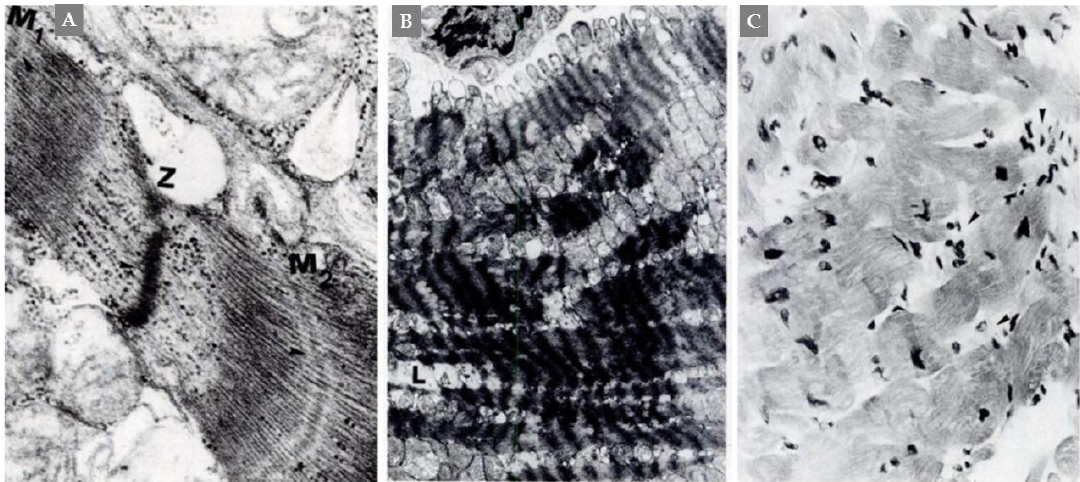
Figure 4. A case of catecholamine-induced “dilated cardiomyopathy”. Panel ( A ), detail of contraction bands that suggests mechanism of damage produced by supercontraction. Two hypercontracted hemisarcomeres delimited by arrows (Z-M1) and (Z-M2) are shown. Between them, initial myofibrolysis is evident. Panel ( B ), supercontraction of sarcomeres associated with intracellular Ca overload and progressing focally to myofibrolysis (L). Panel ( C ), contraction band necrosis of myocardiocytes with foci of inflammatory reaction (arrows). From Frustaci et al., Chest 1991:382-85 with permission. 13. Is There a Common Thread Tethering the Cardiac Manifestation Induced by